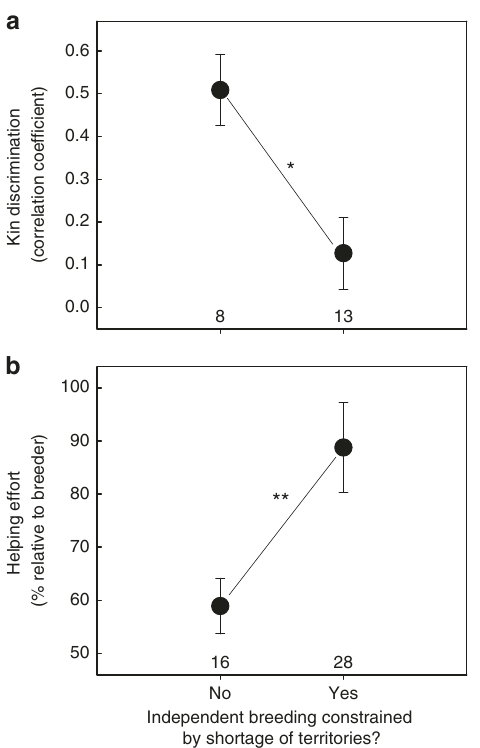
Fig. 1 Territory shortage affects helping behaviour in cooperatively breeding birds. a Helpers in 8 species with no territory shortage mainly direct care to kin, whereas levels of kin discrimination are low (i.e., helpers do not provision kin more than non-kin) in 13 species in which a shortage of vacant territories constrains independent breeding (PGLS model: P = 0.011; the model output is provided in Supplementary Table 1). b As a result, helping effort (mean % offspring food provisioning per helper, relative to breeders) in the 28 species with territory shortage is higher than in the 16 species in which independent breeding is not constrained by territory shortage (PGLS model: P = 0.009; the model output is provided in Supplementary Table 2). Data points and errors bars show means ± standard errors. Numbers re fl ect the number of species. Asterisk and double asterisks re fl ect signi fi cant effects with P < 0.05 and P < 0.01, helping effort.